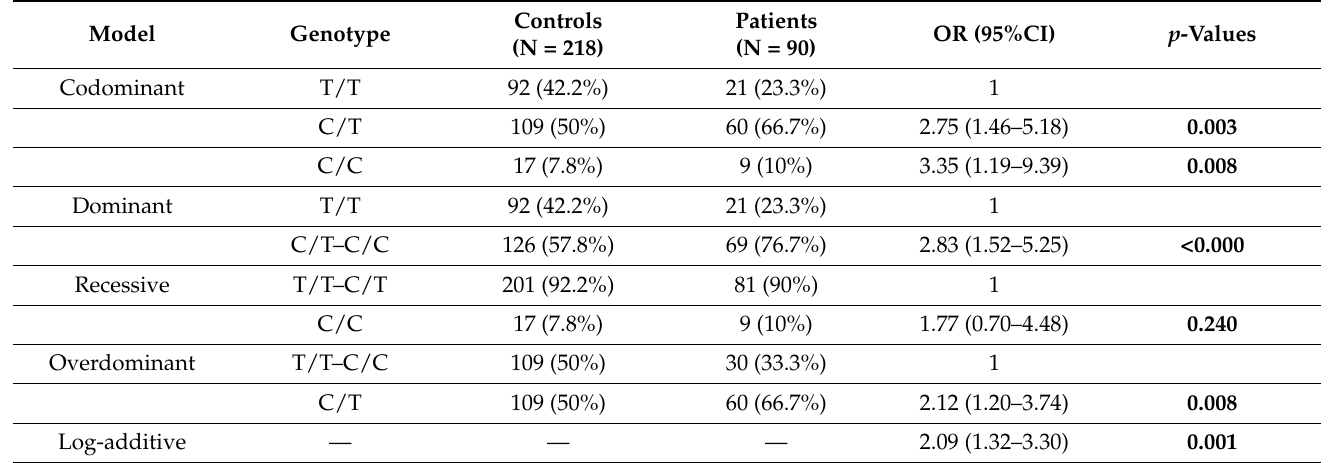
Table 3. Genetic association models for asthma risk.